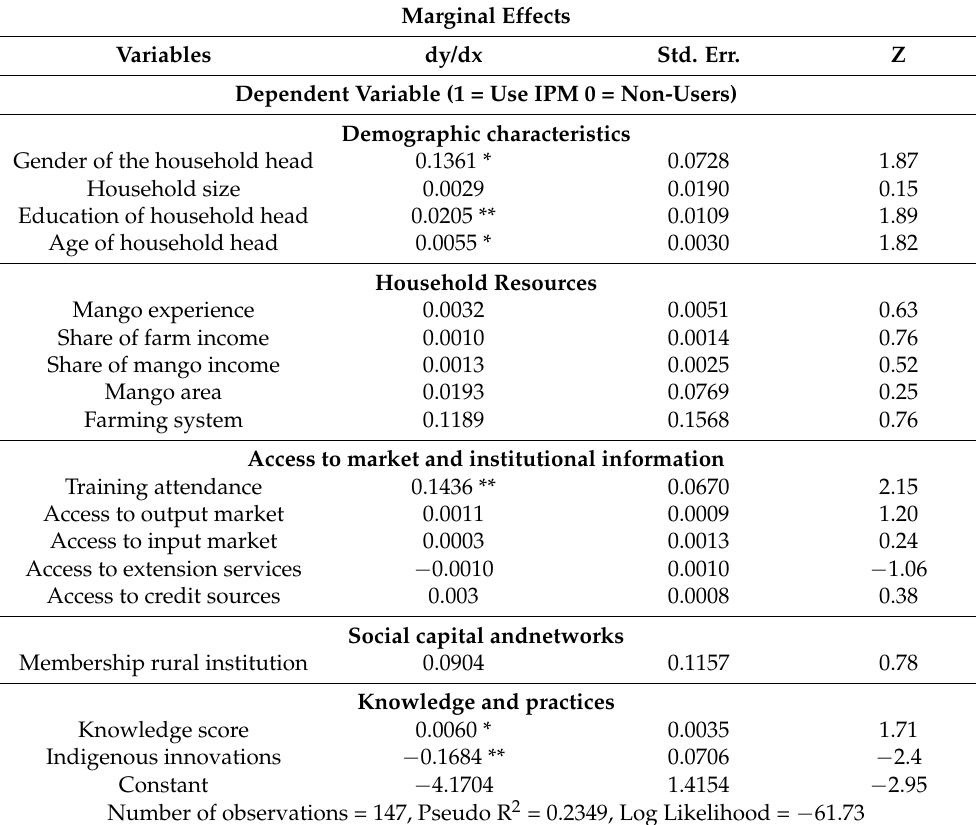
Table 3. Marginal effect of factors influencing the adoption of fruit fly integrated pest management (IPM); Probit